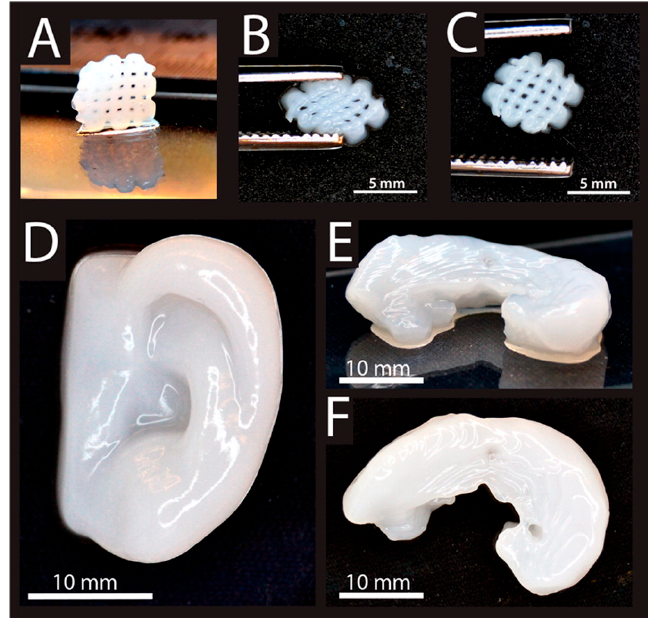
Figure 9. 3D printed constructs made of a composite hydrogel (alginate + nanofibrillated cellulose) seeded with human chondrocytes. ( A ) 3D printed small grids (7.2 × 7.2 mm 2 ). Deformed grid during ( B ), and after ( C ) squeezing. ( D ) 3D printed human ear. ( E , F ) 3D printed sheep meniscus. Reproduced from [115] with permission Copyright (2015) American Chemical Society.